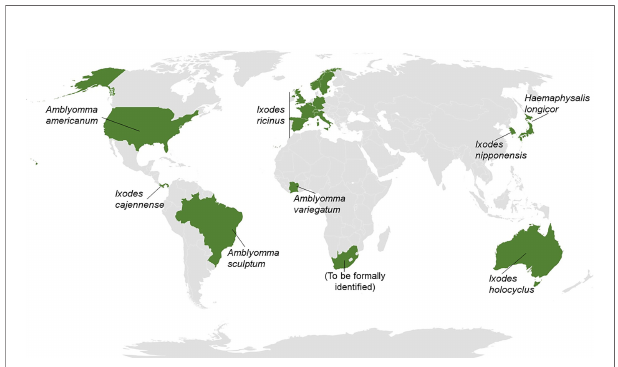
FIGURE 1 | Hard ticks as the cause for a Gal syndrome. Worldwide map re fl ecting (in green) the 17 countries in which hard ticks from different species have been detected to be causative of a Gal syndrome (AGS). The list of countries includes Australia, United States, Germany, France, Spain, Belgium, Switzerland, Sweden, United Kingdom, Italy, Norway, Korea, Japan, Panama, Brazil, Ivory Coast, and